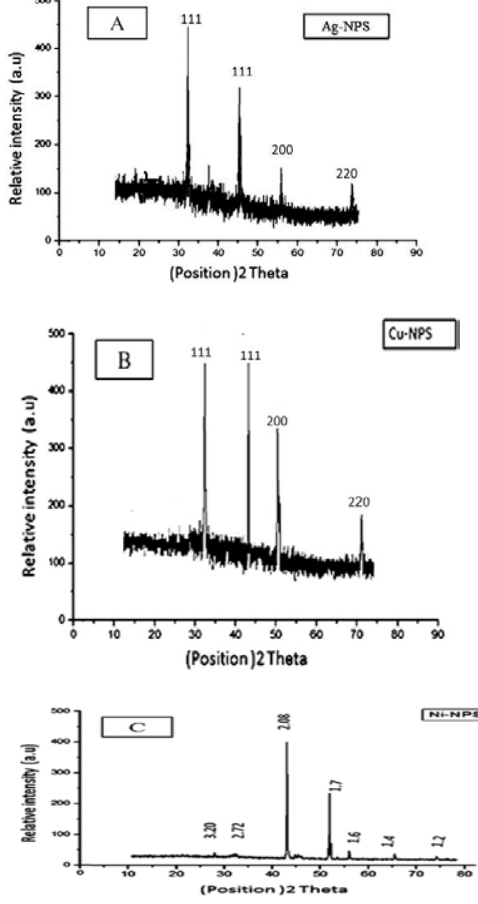
Fig. 2. XRD analysis for Ag-NPS, CU-NPS, Ni-NPS, synthesized by